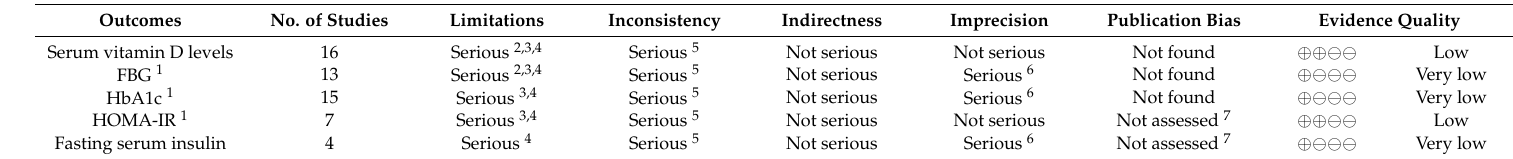
Table 3. Evidence quality rated using the GRADE